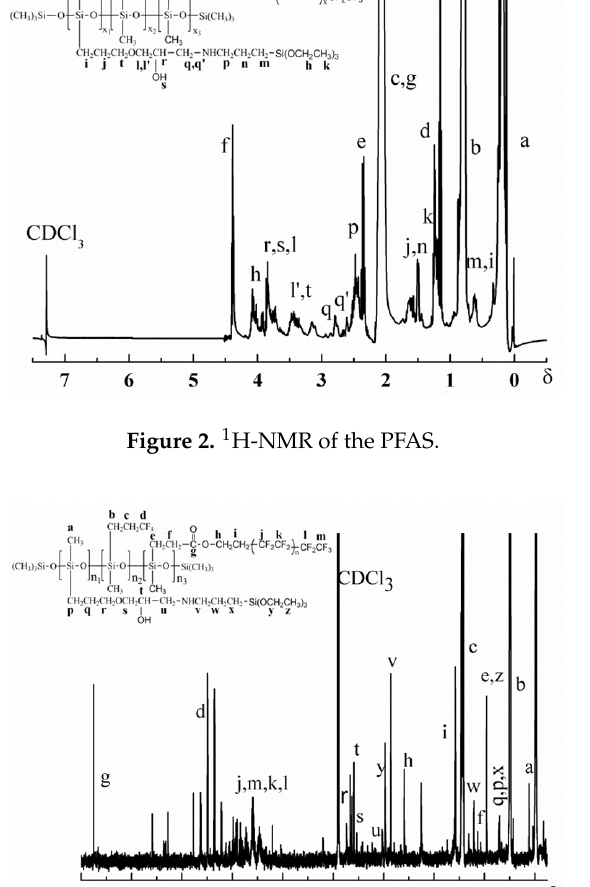
Figure 3. 13 C ‐ NMR of the PFAS.